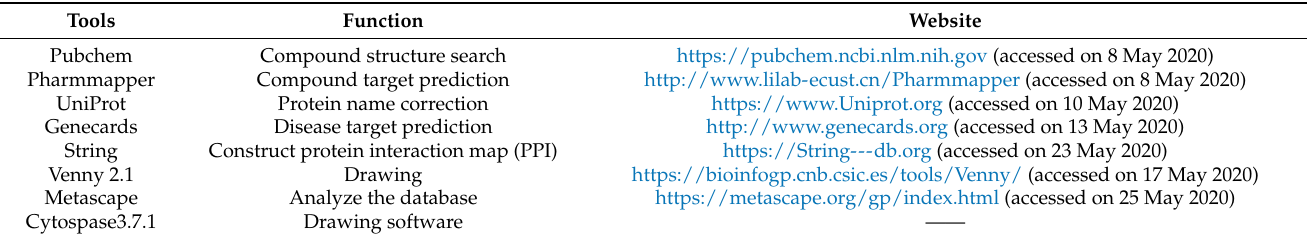
Table 1. Databases and analysis software related to Network